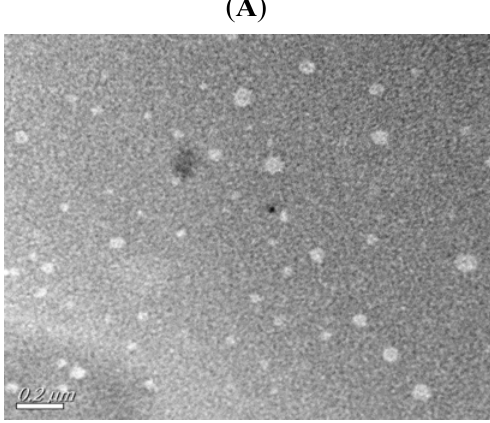
Figure 2. Characteristics of liposomal celastrol. TEM micrographs of celastrol-loaded liposomes prepared by ethanol injection method ( A ); Size distribution and zeta distribution determined by laser particle size analyzer ( B and C